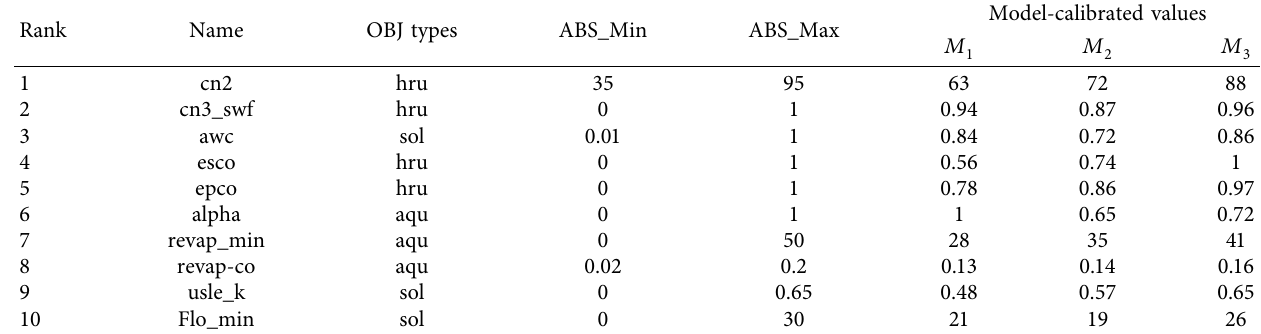
Table 8: With developed models, the best calibration parameters and their ftted